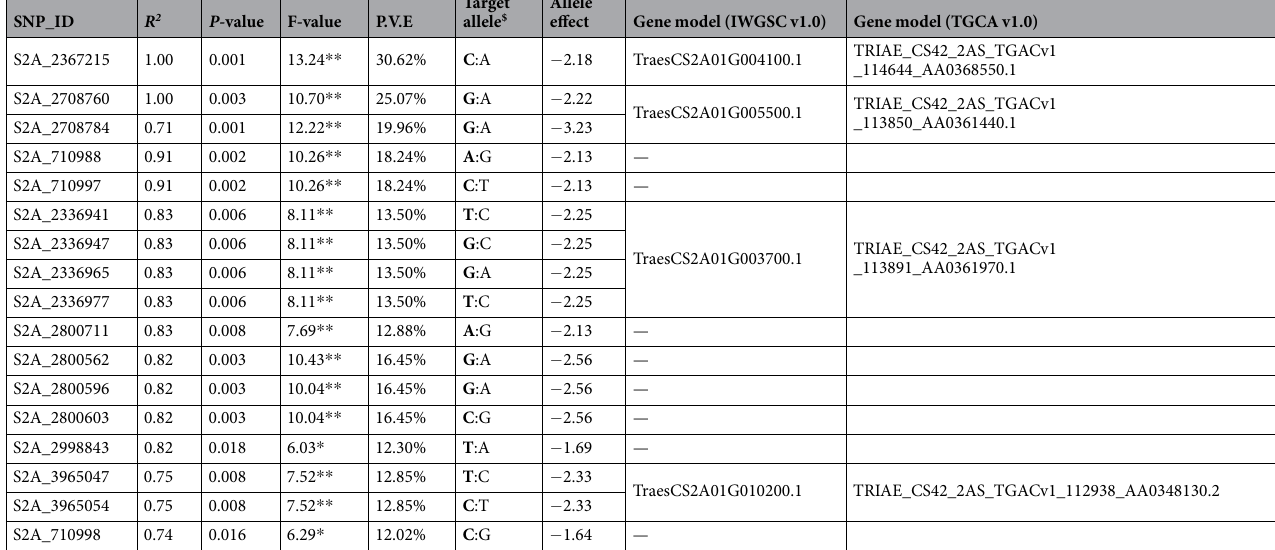
— Table 2. Linkage disequilibrium (LD) between the specific Sr38 marker (VENTRIUP-LN2) and SNPs located on chromosome 2A in the TRP2015. Single marker analysis between the significant SNPs and stem rust resistance. Gene models underlying them based on the IWGSCv1.0 and TGAC v1.0 data bases. R 2 Linkage allele is associated with increasing stem rust